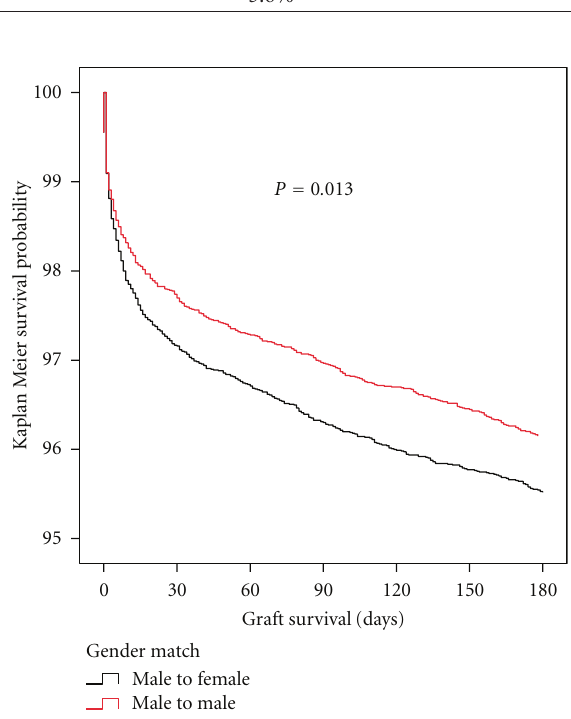
Figure 1: Kaplan Meier plot of death censored graft survival in the first 180 days after kidney transplantation Black line is female recipients of male donor kidneys; red line is male recipients of male donor kidneys. Note that the y -axis of survival analysis begins at 100% and ends at 95%. The di ff erence in survival occurs in the first 30 days, and thereafter the slopes of the survival curves are nearly